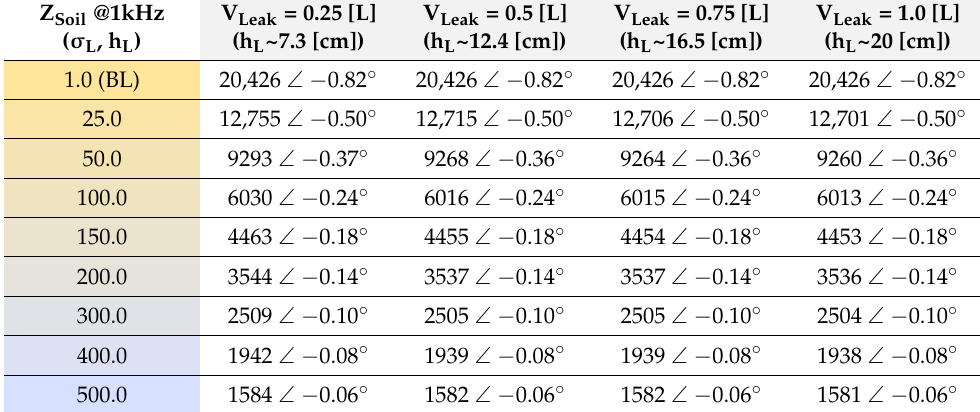
Table 2. Z Soil (j ω ) [ Ω ] at 1 kHz for variables h Leak ( V Leak ) and σ Leak (in µ S/cm), starting from a confined leak zone baseline (BL) conductivity equal to the adjacent ground’s one, i.e., fully dry soil. The background colors act as a reminder for the arid soil (yellowish) gradually becoming wet